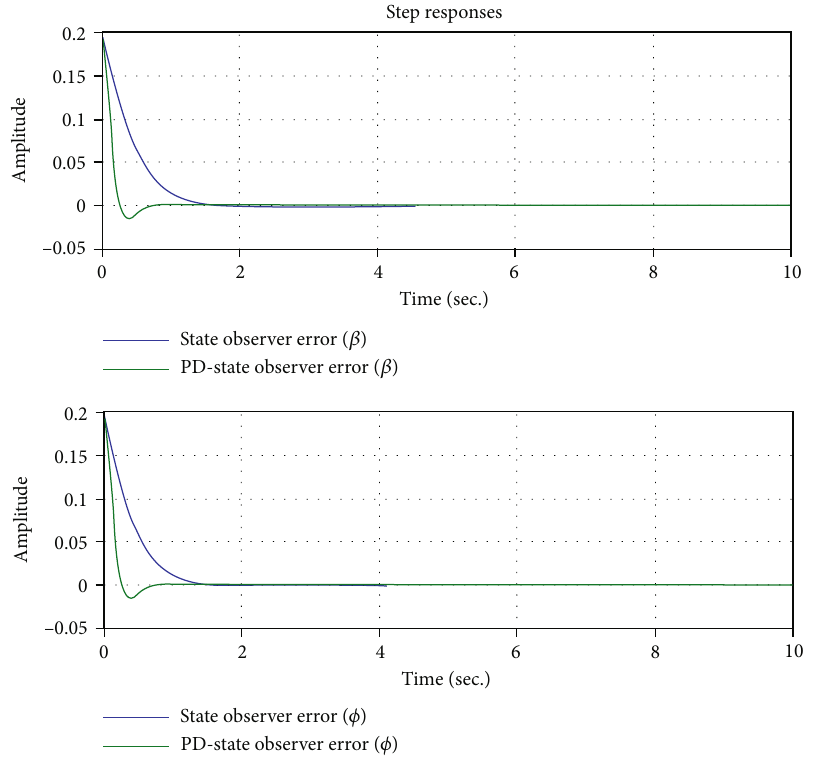
β = 0 : 1 I 2×2 2×2 .